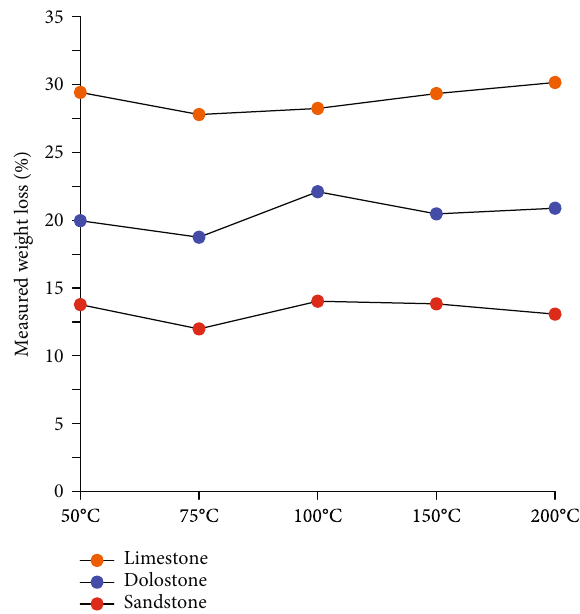
Figure 2: Measured weight loss of rock grains during the simulation, measured by the weight di ff erence of rock grains before and after the